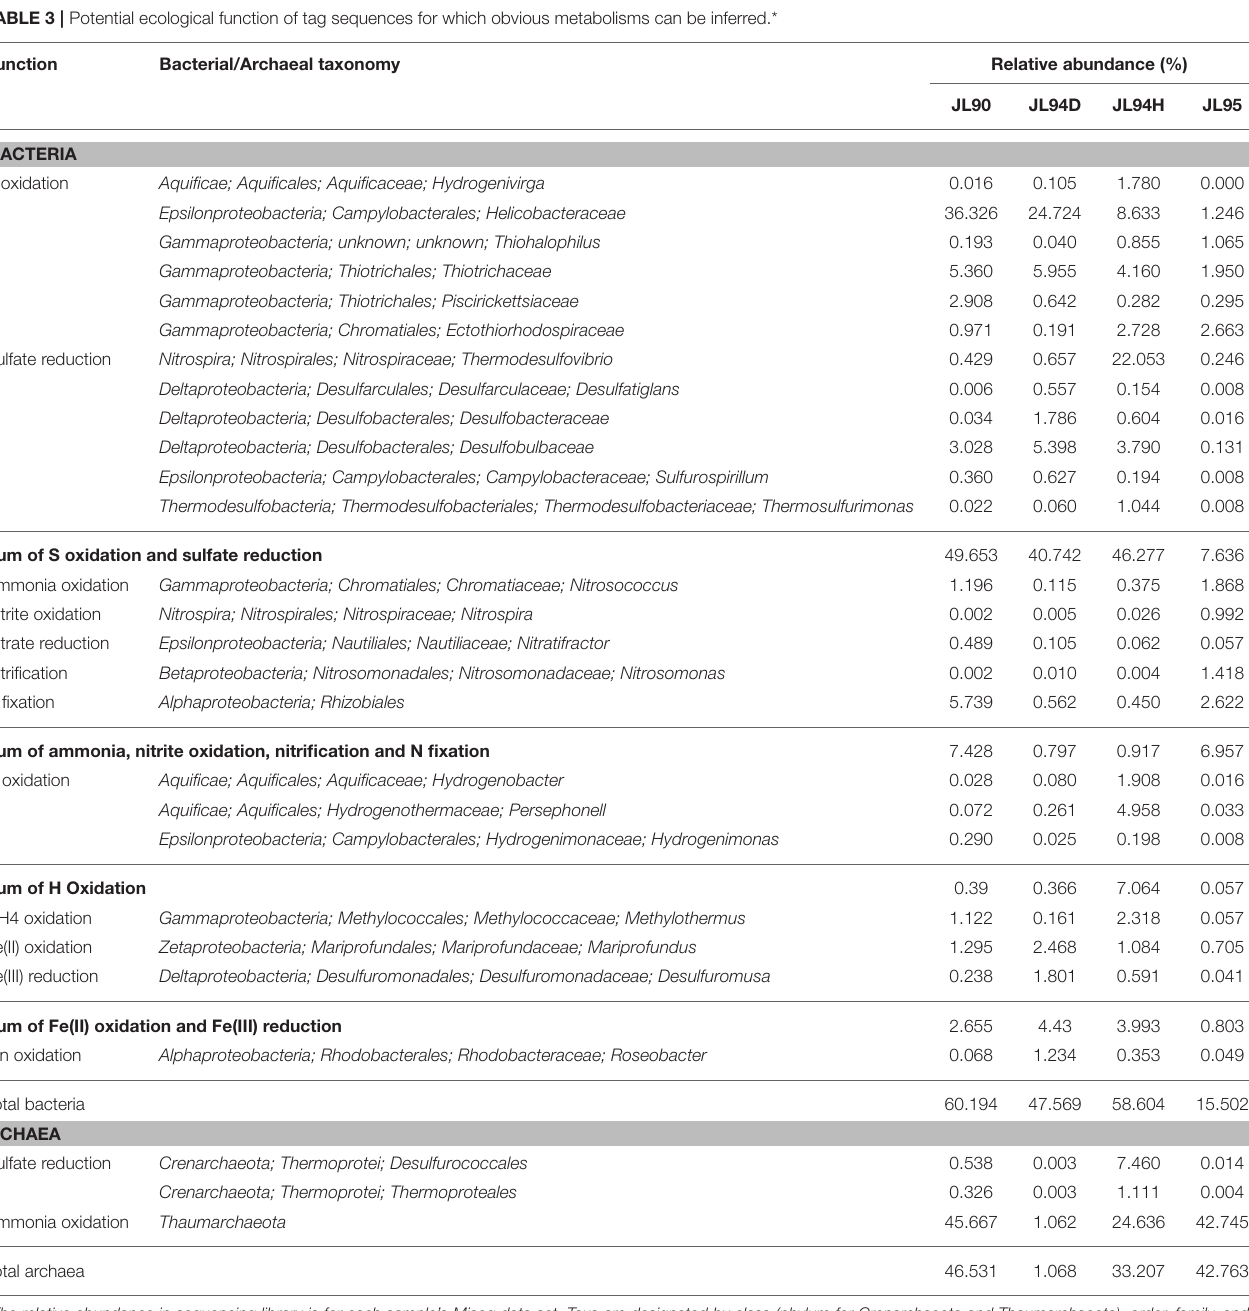
compounds and O 2 were steadily supplied into the chimney habitats. Epsilonproteobacteria were known to play a significant role in carbon, nitrogen and sulfur cycling and had consistently shown to be the most numerically abundant bacteria in sediment (López-García et al., 2003), hydrothermal fluids (Huber et al., 2010), hydrothermal plumes (Nakagawa et al., 2005), and vent chimneys (Campbell et al., 2001; Opatkiewicz et al., 2009; Dahle et al., 2013). Based on our data, Epsilonproteobacterial amplicons ranged from 1.3% at high-temperature vent chimneys to